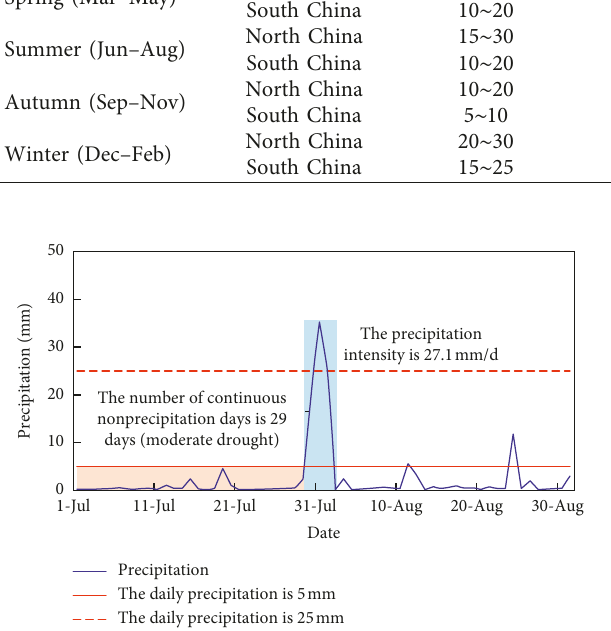
Figure 3: Drought-flood abrupt alternation